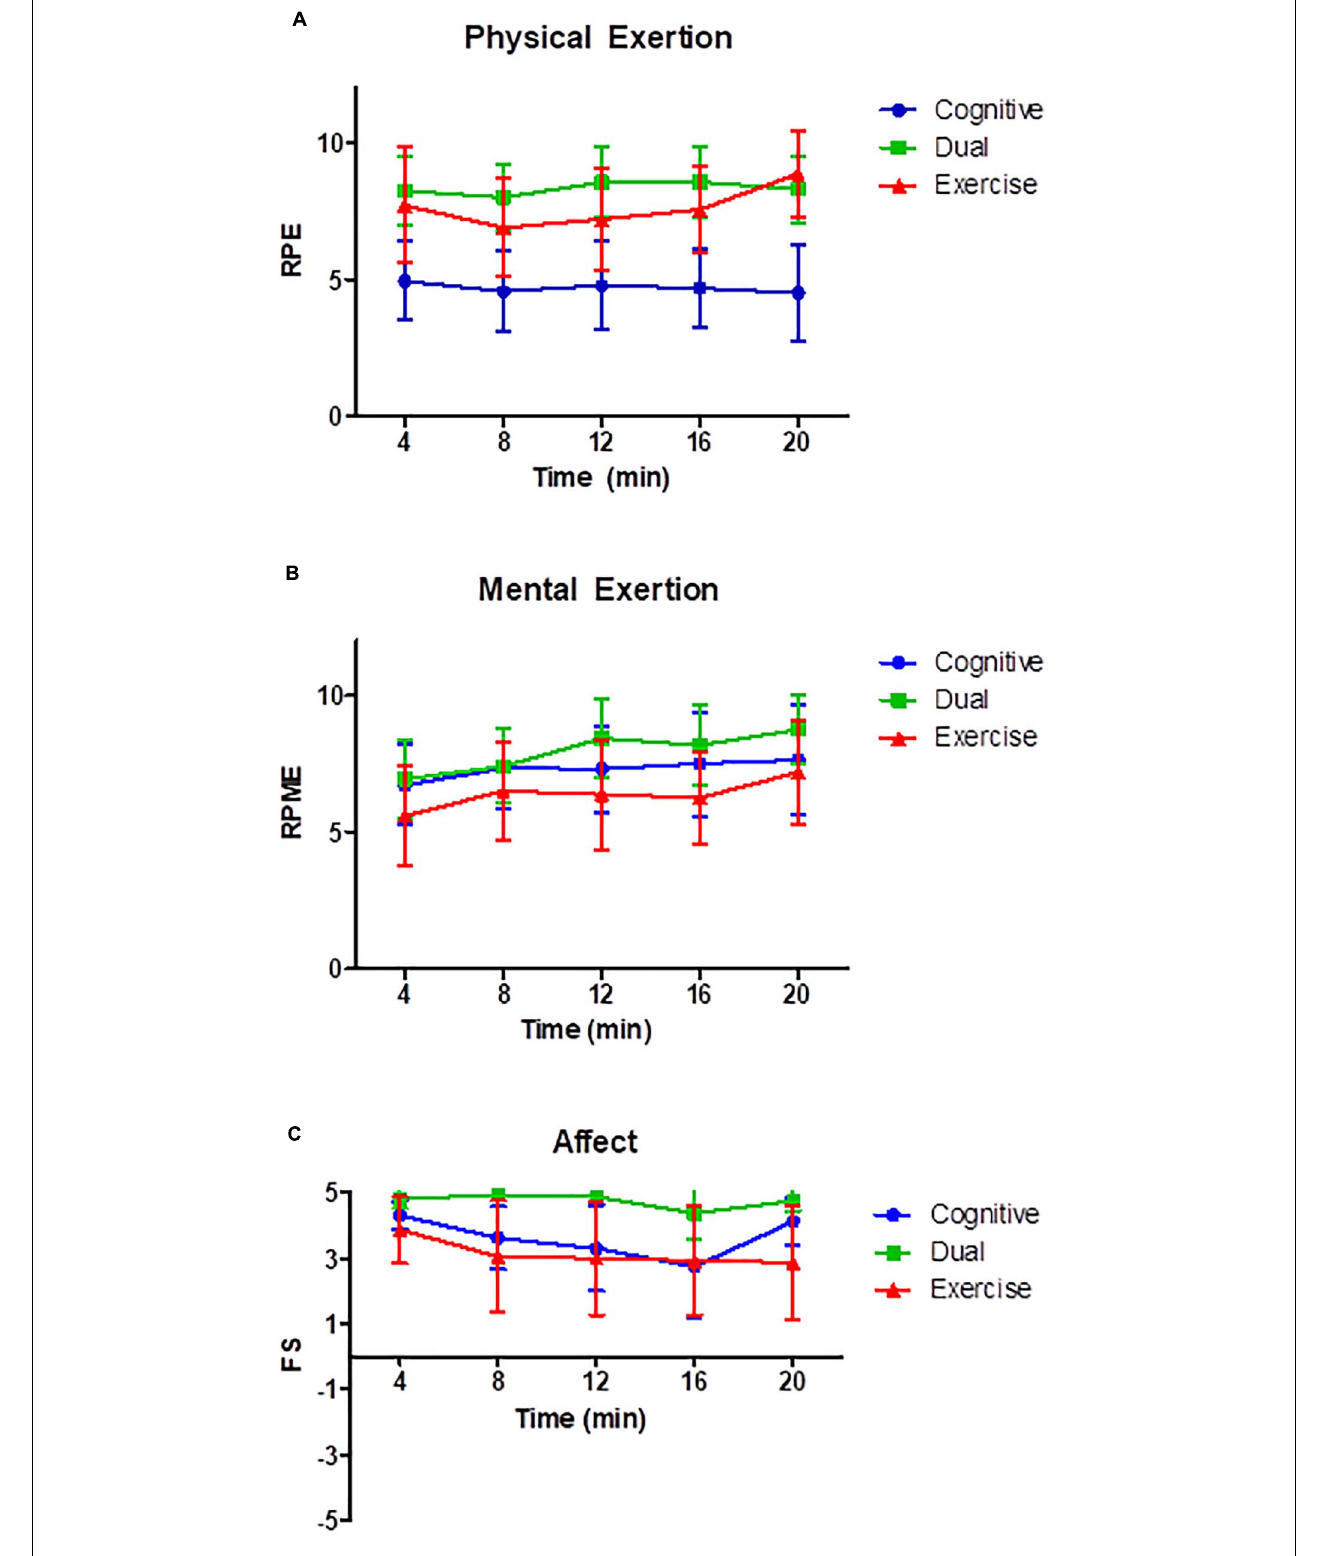
FIGURE 1 | (A–C) Ratings of physical exertion (A) , mental exertion (B) , and affect (C) during the experimental manipulation by condition. RPE, ratings of perceived physical exertion; RPME, ratings of perceived mental exertion; FS, feeling state.